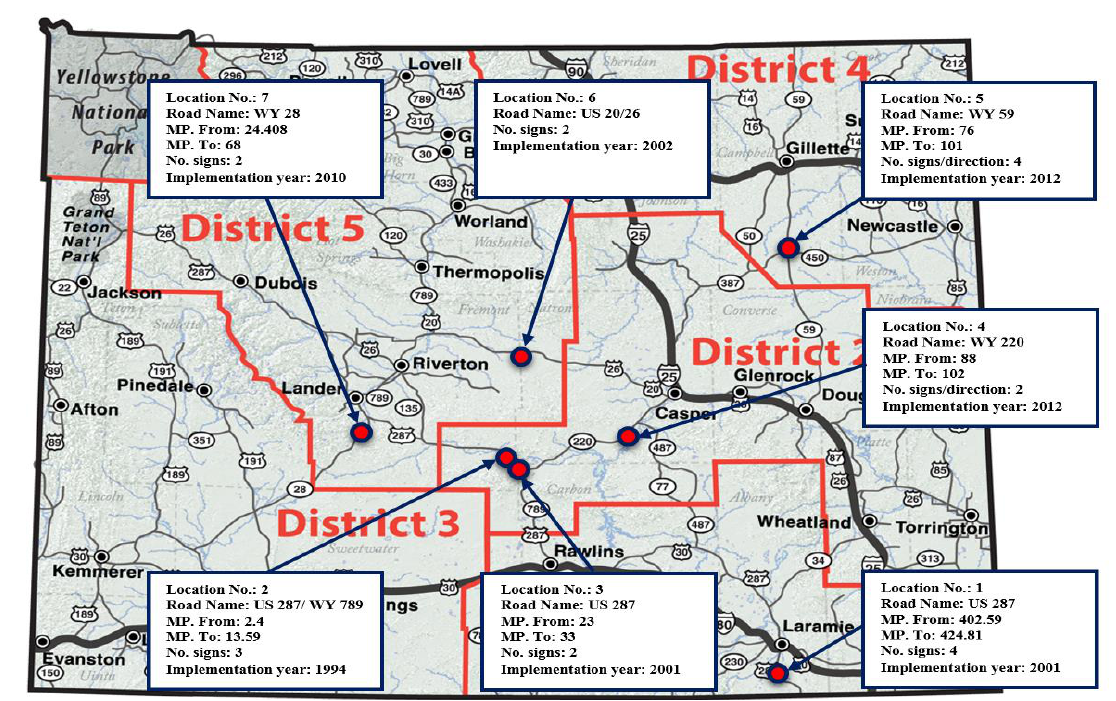
Figure 2: Headlight sign locations in Wyoming